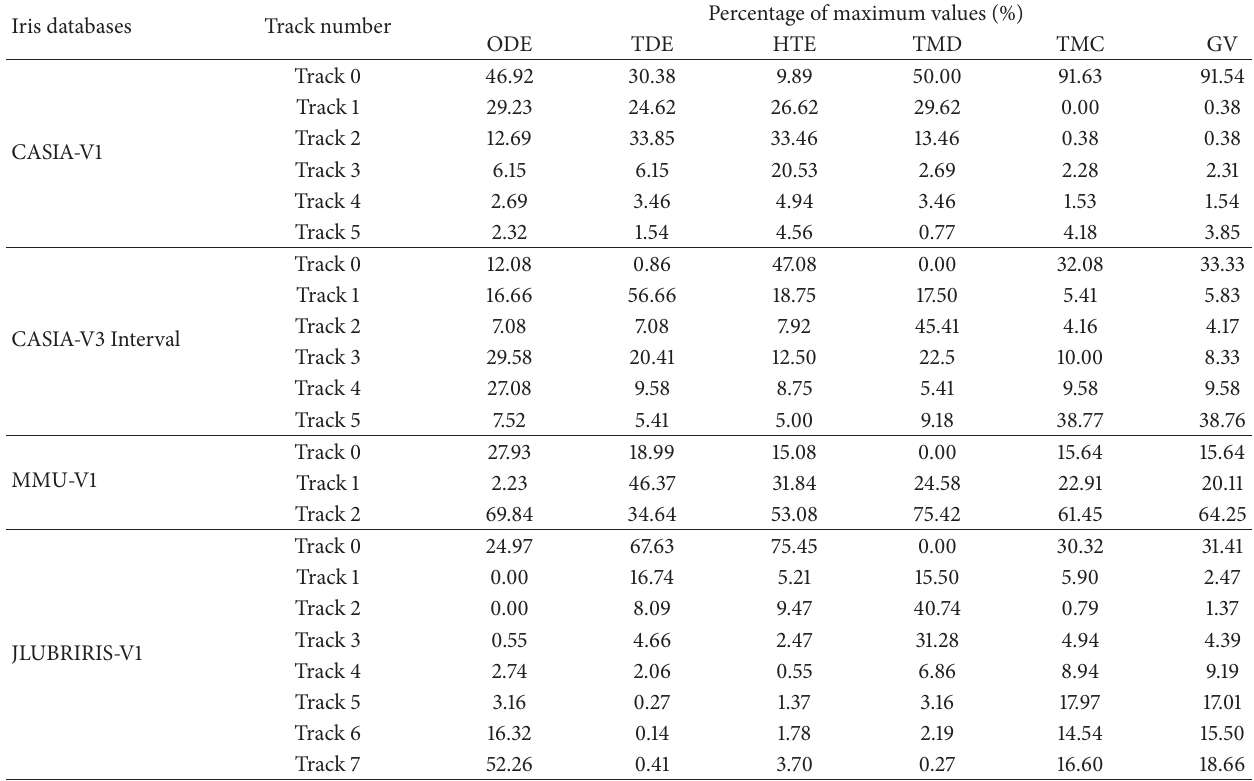
Table 2: Percentage distribution of maximum